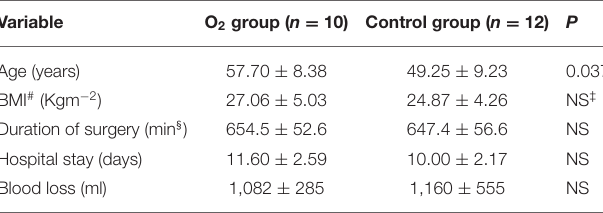
TABLE 1B | Patient laboratory data for the O 2 and control groups.